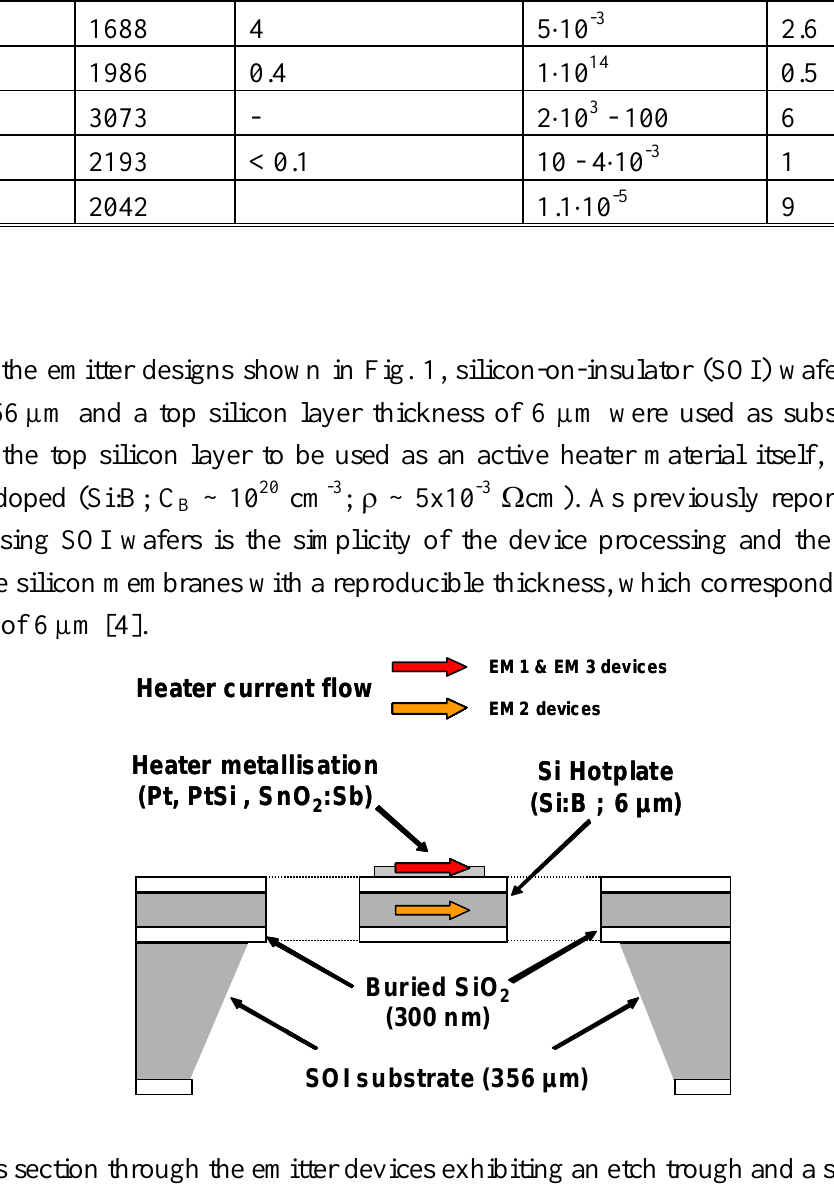
Figure 2. Cross section through the emitter devices exhibiting an etch trough and a spider-like hotplate structure for thermal insulation. The electrical isolation of hotplate and heater is assured by a 700 nm thick layer of SiO on top of the Si:B membrane. Arrows indicate the positioning of the heater current 2 flow in the individual